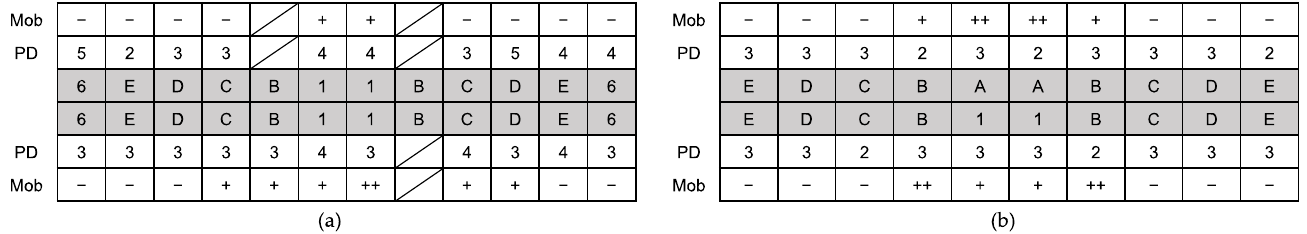
Figure 3. Periodontal pocket depth (PD) and mobility of teeth (Mob): ( a ) Older sister (seven years and eleven months); ( b ) Younger sister (six years and one month).